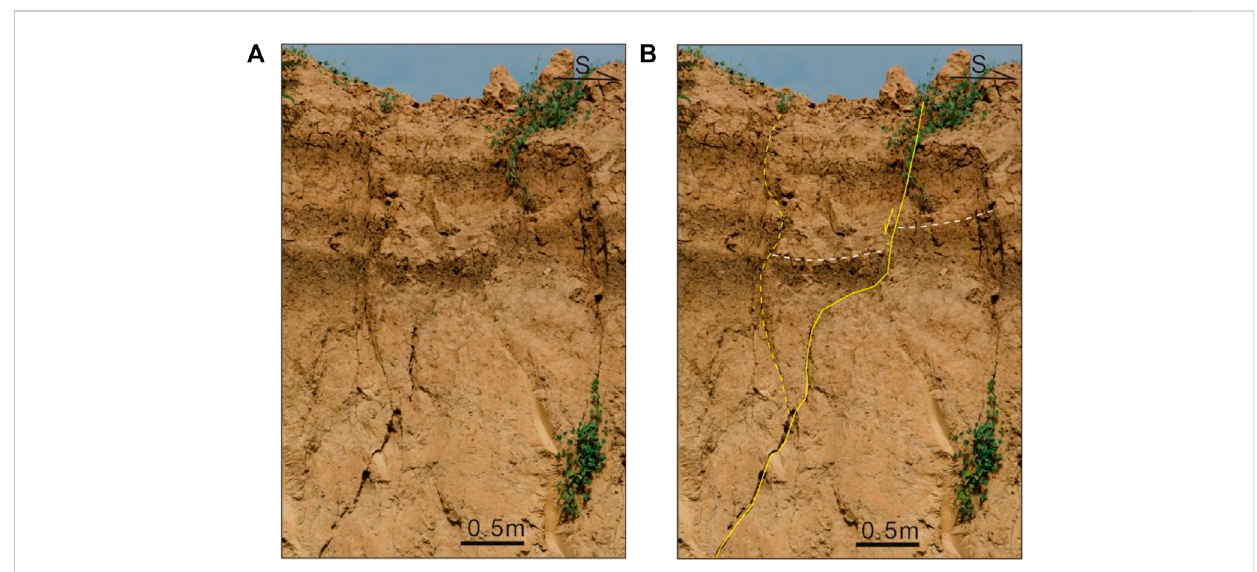
FIGURE 8 (A) Photograph and (B) interpreted sketch of vertically displaced Holocene gray-black soil layer. The yellow solid line and the dashed line represent normal faults, and the white dashed line indicates vertical offset strata